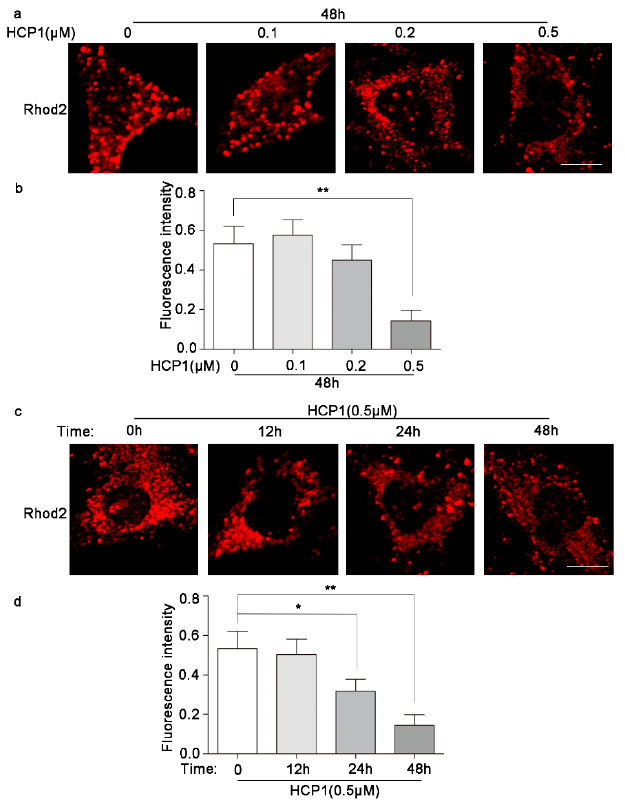
Figure 7. HCP1 reduced the level of Ca 2+ in mitochondria. ( a – d ) HDFs were treated with DMSO or HCP1 (0.1, 0.2, 0.5 μ M) at indicated concentrations for 0 h, 12 h, 24 h, and 48 h, Rhod2 was used to detect the level of Ca 2+ in mitochondria. Scale bar: 20 μ m. Data are presented as means ± SEM, * p < 0.05, ** p < 0.01, n =